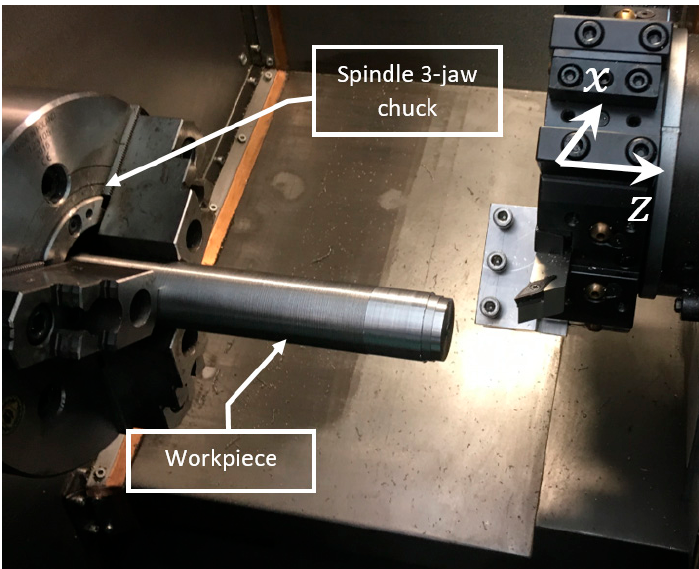
Figure 2. The machine–tool–workpiece system.